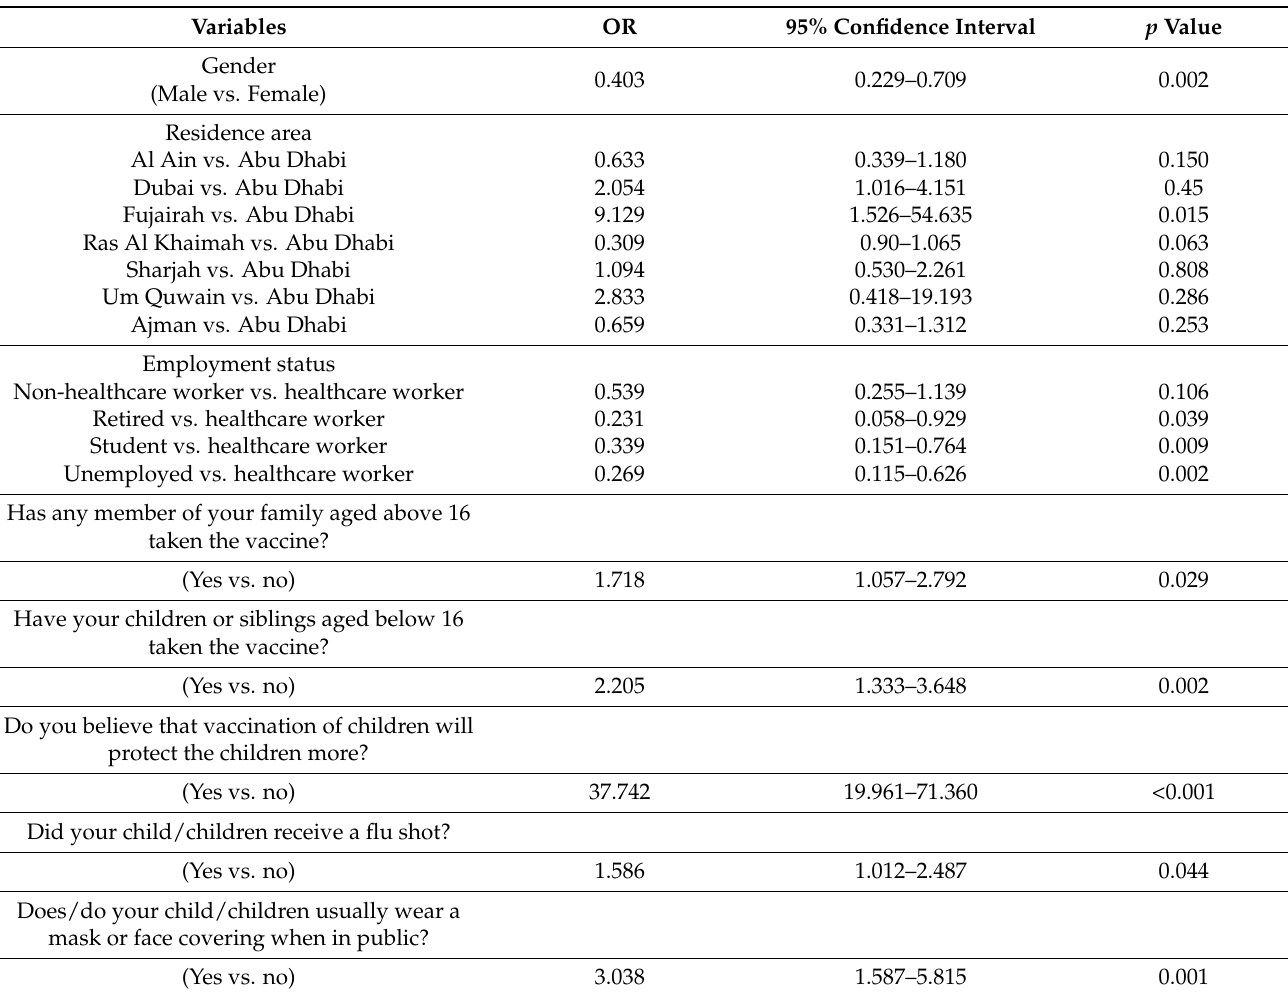
Table 7. Logistic regression taking the parents’ acceptance of the COVID-19 vaccine as the dependent variable and all other factors as the independent variables ( n =